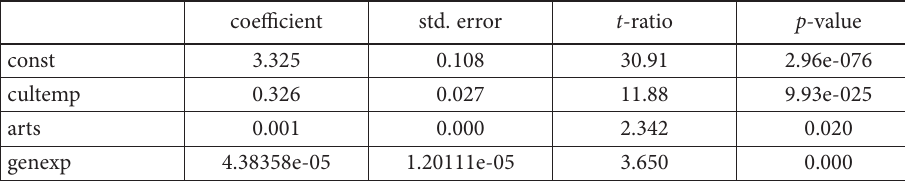
Table 8. 2011–2017 panel regression analysis (source: compiled by the